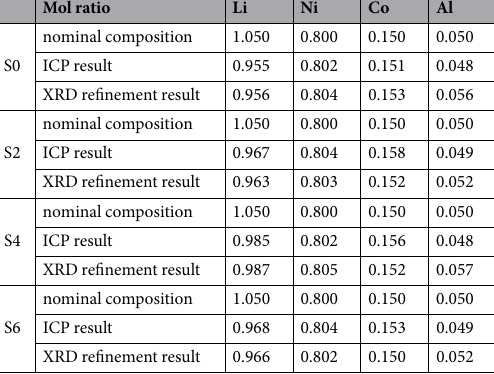
Table 2. chemical compositions for all